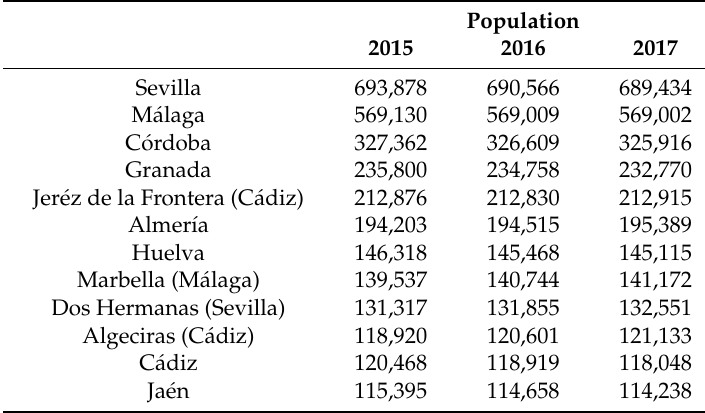
Table 2. Cities with the highest population in Andalusia. Source: National Institute of Statistical of Spain [23].